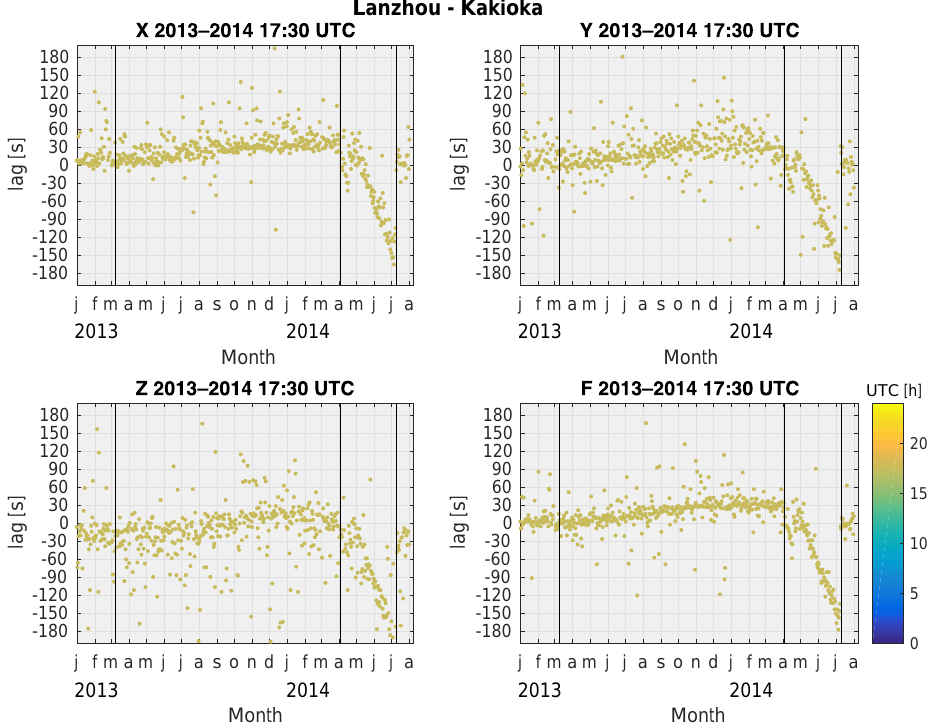
Figure 3. Time lags calculated every day during 1h around 17:30UTC comparing Lanzhou and Kakioka data for each component of the magnetic field X,Y,Z and F . The F component is measured every 5s at Lanzhou. The vertical lines indicate from left to right: the time when the GPS synchronization became unavailable, the time when the data logger was rebooted and the time when the GPS synchronization was